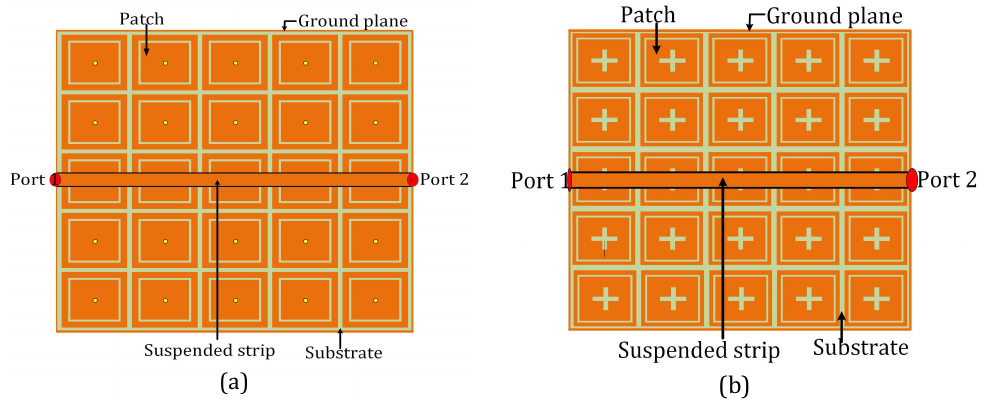
Figure 4. A 5×5 array of ( a ) the mushroom EBG and ( b ) the EBG with plus-shaped slots with suspended strips.